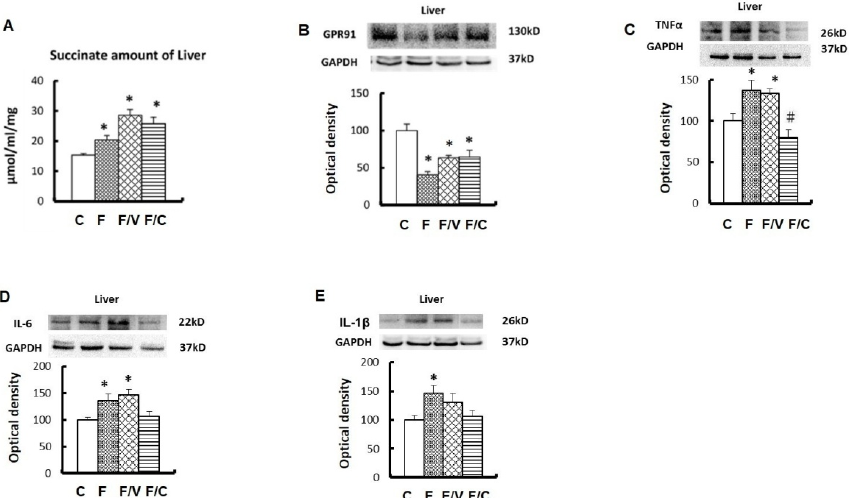
Figure 2. The contents of succinate in the liver tissues, the expressions of the GPR91 protein, and the expressions of proinflammatory mediators, such as TNF- α , IL-6, and IL-1 β , among the groups. The succinate levels in the liver tissues were evaluated by ELISA ( A ) . Representative Western blot gels and densitometric analyses of proteins in GPR91 ( B ), TNF- α ( C ), IL-6 ( D ), and IL-1 β ( E ) among the study groups. Western blots data are expressed in percentage to the control group denoted as 100%. Data are presented in mean ± SEM, n = 8 in each group. * shows significance in comparison with the control group, and # with the fructose group, by one-way ANOVA with Bonferroni